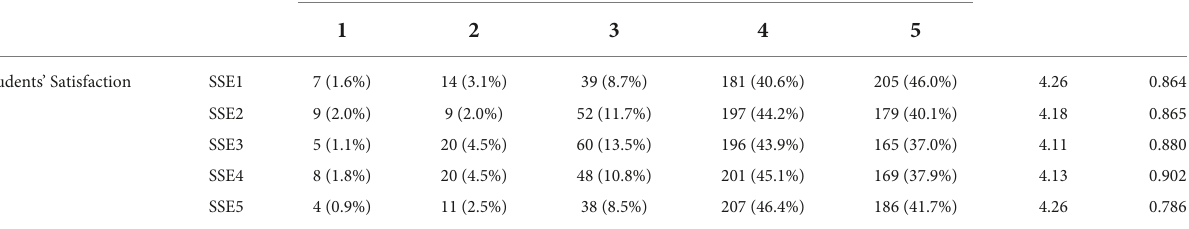
TABLE 12 Measuring students’ satisfaction with using e-learning systems (SSE). Factor and